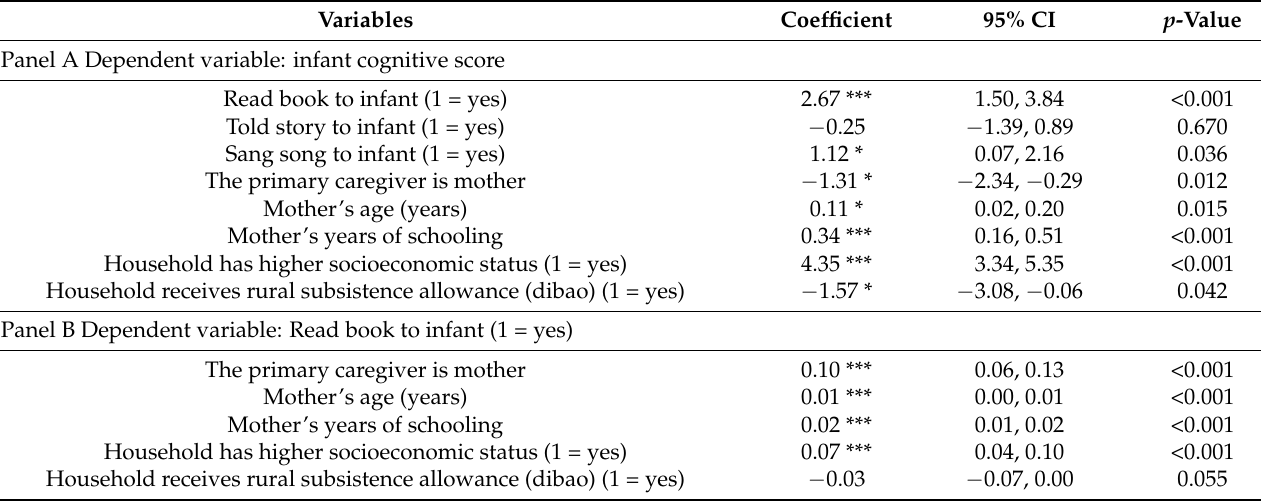
Table A2. Correlations between infant cognitive scores, stimulating parenting practices and household characteristics using generalized structural equation model